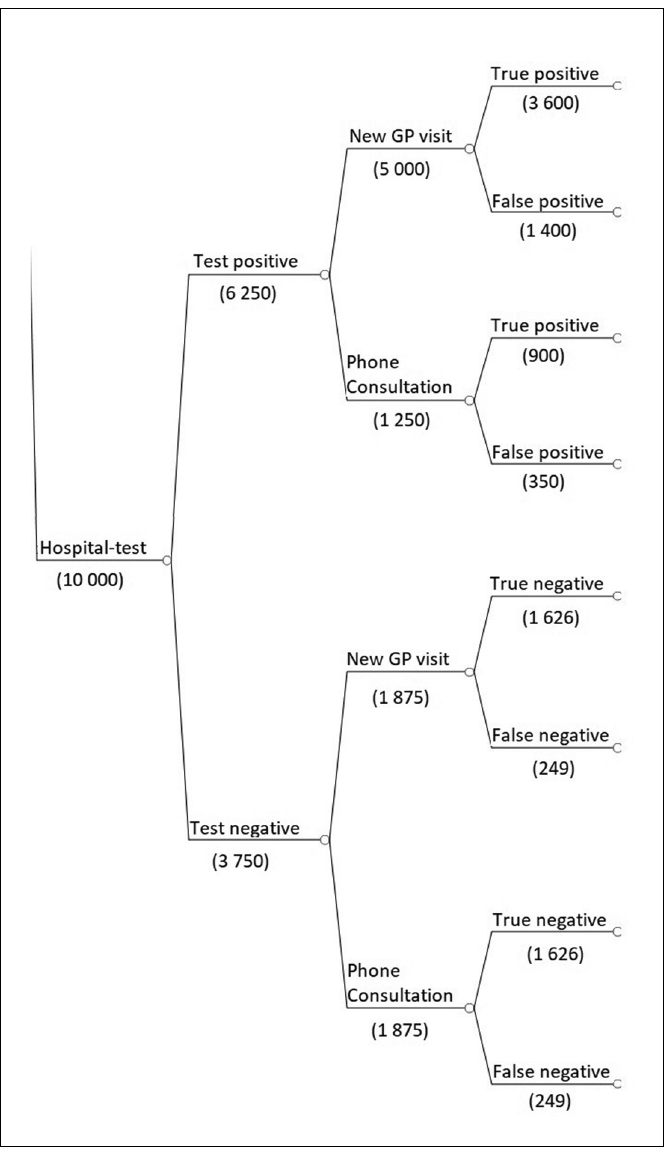
Figure 1. Key structure for the decision model (the number of patients is used for illustrative